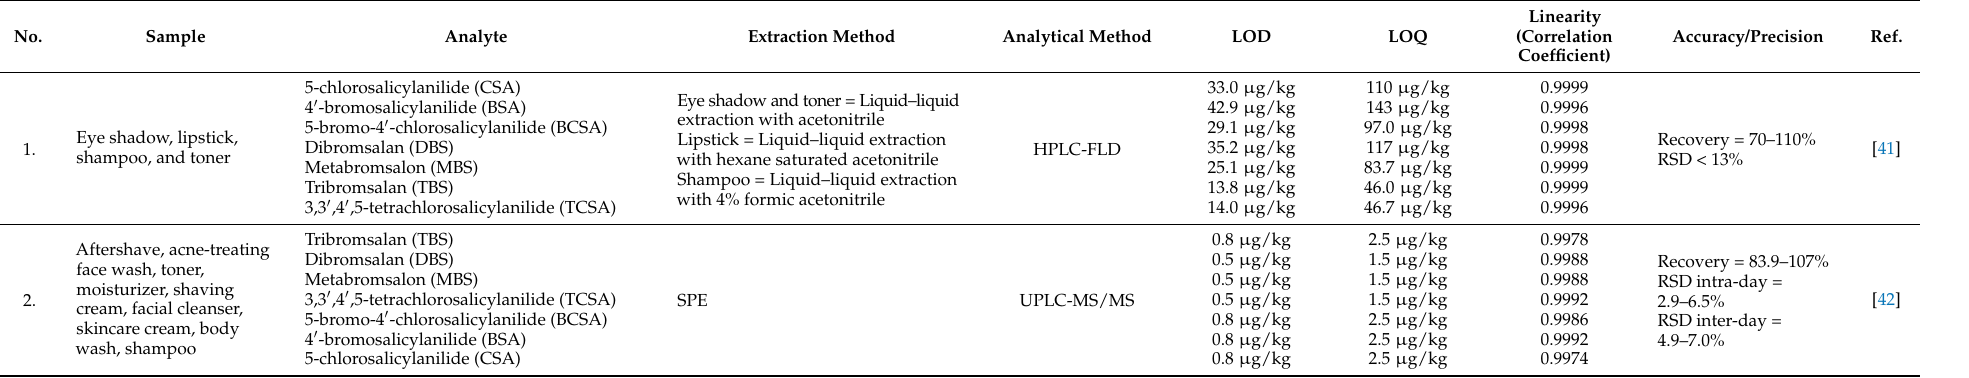
Table 6. Analytical method for determining halogenated salicylanilides in